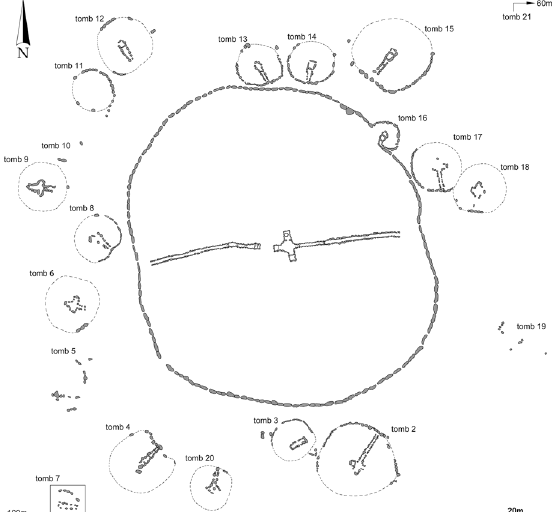
Figure 1 . A plan view of the passage tomb cemetery at Knowth, Co. Meath, showing the focal mound, Site 1, surrounded by 20 smaller or satellite tombs (after Eogan and Cleary, 2017, Figure